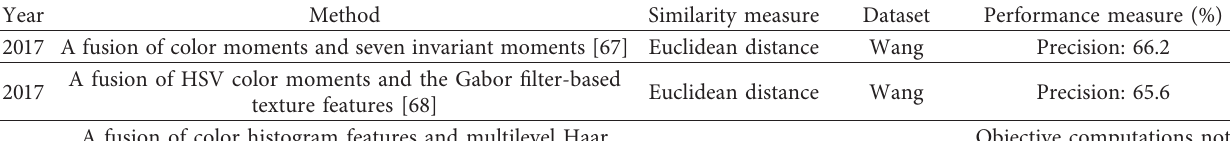
Table 5: Summary of feature fusion-based image retrieval